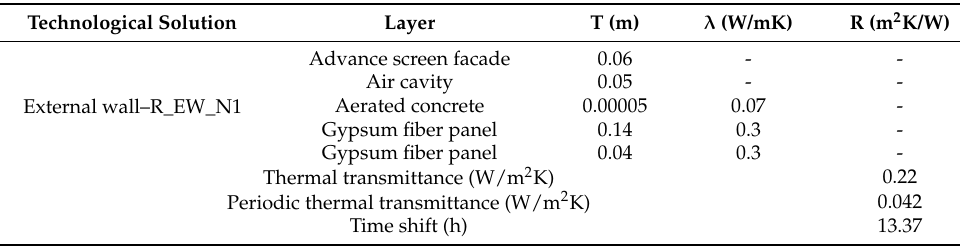
Table A21. Possible redevelopment measure for external wall (R_EW_N1) with the same transmit- tance of the reference building.